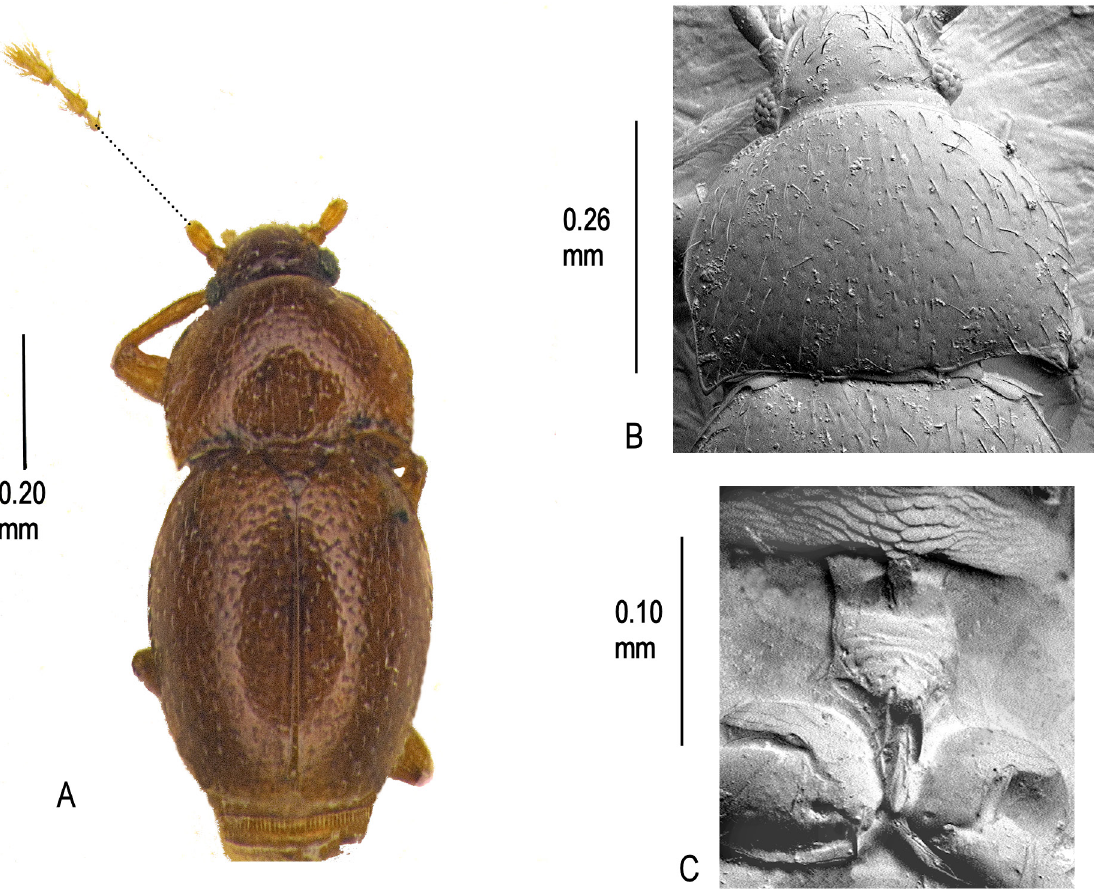
Fig. 81 . Cissidium subfaustum sp. nov. A . Habitus. B . Pronotum, × 410. C . Mesoventrite showing median process of collar, mid-keel and keel, ×